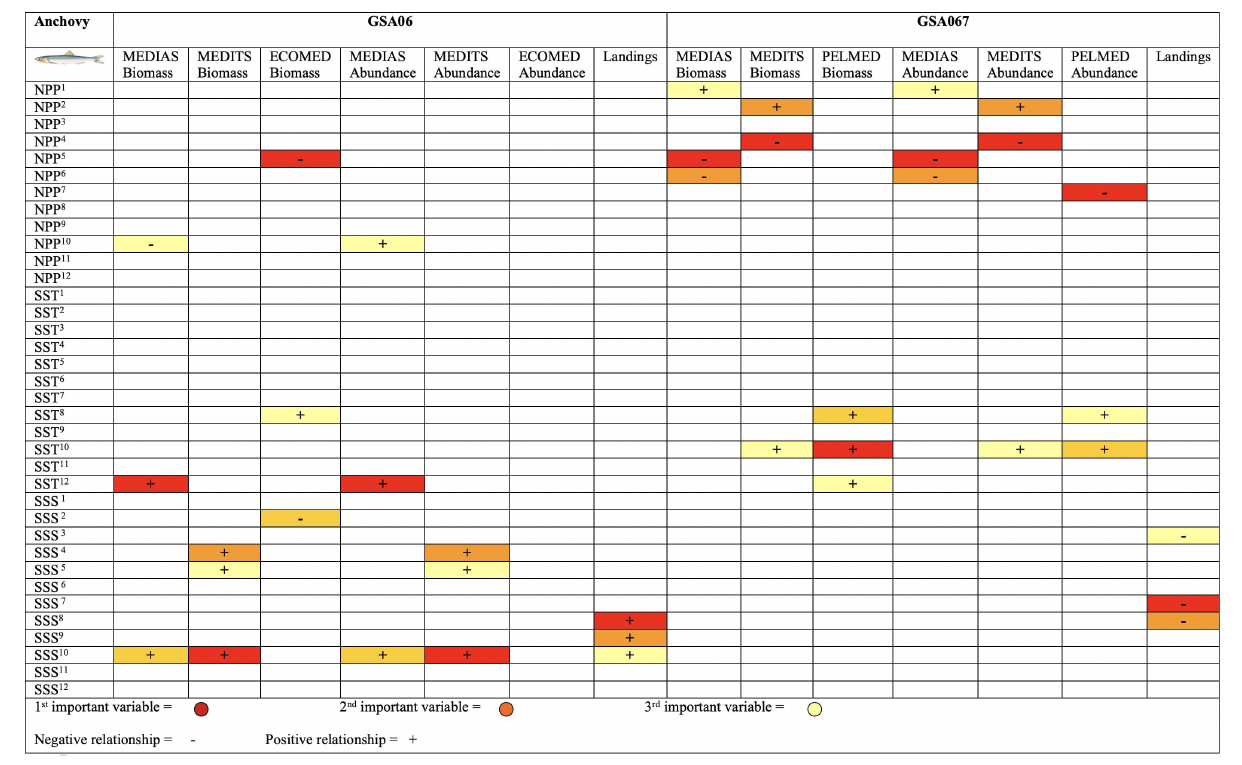
Frontiers in Marine Science |